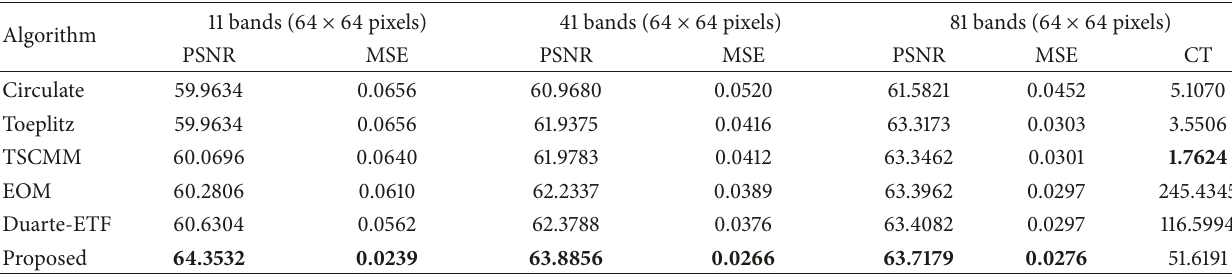
Figure 5: The subjective quality of different CS measurement matrices, from left to right: (a) original, (b) Circulant, (c) Toeplitz, (d) TSCMM, (e) EOM, (f) Duarte-ETF, and (g) proposed method. Table 1: MSE and PSNR of different matrixes of recovery